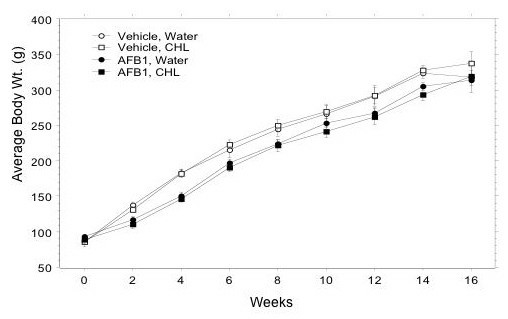
Effects of CHL and AFB1 on body weights. Data are mean (± SE) at each timepoint.